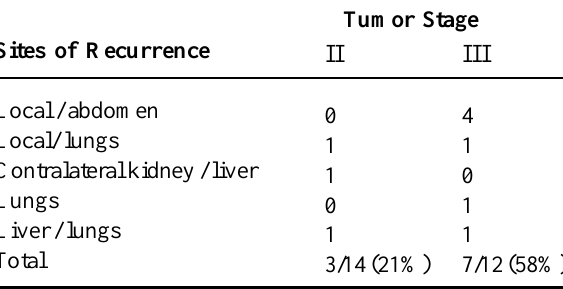
Table 5 – Place of recurrence versus tumor